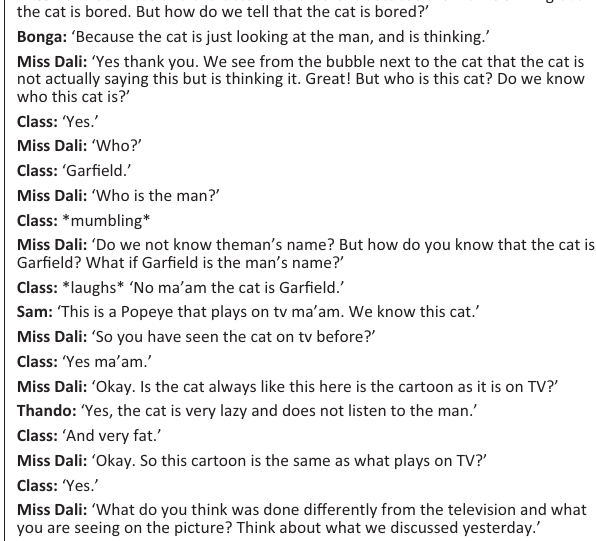
FIGURE 6: Miss Dali Garfield’s lesson. FIGURE 7: Miss Dali Garfield’s